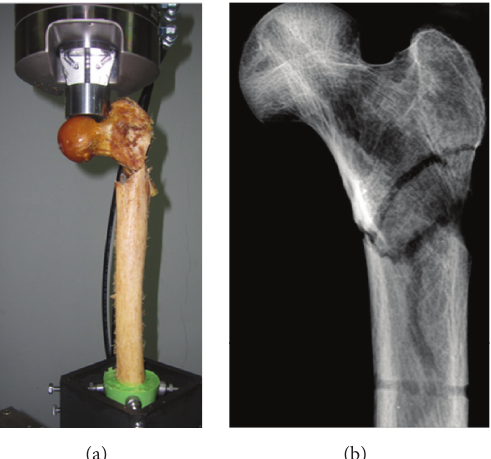
Figure 3: (a) Clinical photograph of a fracture following application of a static compression load to the specimen from which a DHS had been removed. (b) Anteroposterior radiograph of the proximal femur following DHS removal revealing a subtrochanteric fracture pattern. The step-off sign of lateral cortex of femur only observed on barrel hole.